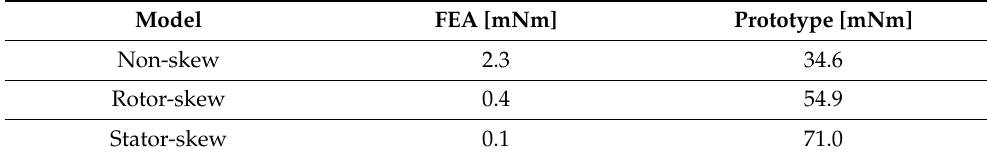
Table 4. Skew designs for the 3 prototypes.